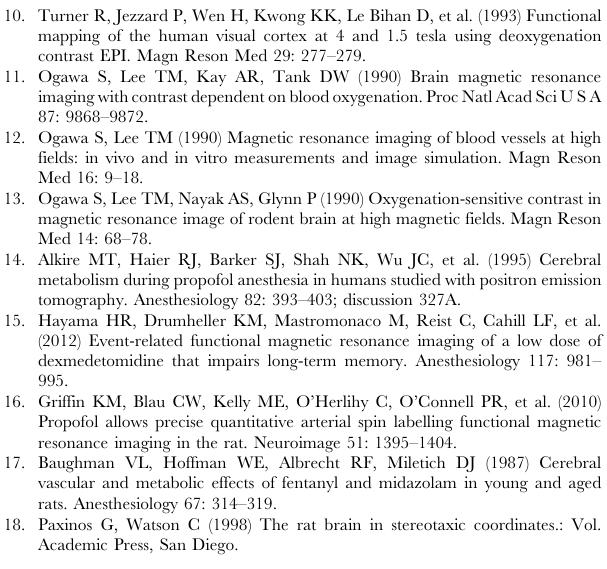
Figure 6. Classification of sedative agents based on their effects on the blood oxygenation level assessed by MRI at 17.2 T. A: The relative oxygenation ratio of isoflurane, sevoflurane, propofol, midazolam, medetomidine and ketamine-xylazine is displayed using a colored disk with variable intensity. Lower color saturation intensity corresponds to lower CBO level, and vice a versa. B: Proposed algorithm to identify anesthetic agents based on relative CBO in the cortex and thalamus as assessed by T2*-oxygenation-ratio. Low signal, T2*- oxygenation-ratio , 50000; High signal, T2*-oxygenation-ratio . 50000.